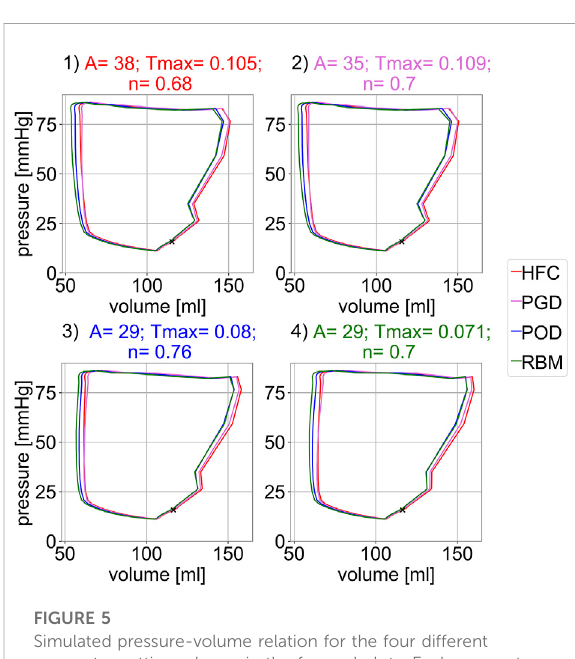
FIGURE 5 Simulated pressure-volume relation for the four different parameter settings shown in the four subplots. Each parameter settingswasoptimizedtooneinterpolated fi ber fi eldobtainedwith thefour compared methods:1) HFC,2)PGD, 3) POD, 4) RBM. Foreachparametercon fi guration(subplot)thepV-loopforallfour interpolated fi ber fi elds are depicted. The marker indicates the diastatic state, i.e. the initial state of the